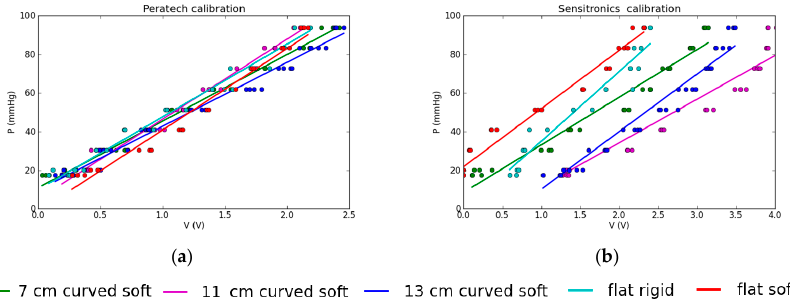
Figure 6. Measured calibration curves for ( a ), Peratech; ( b ) Sensitronics. Calibration points shown as dots. Linear fits for each type of surface shown as